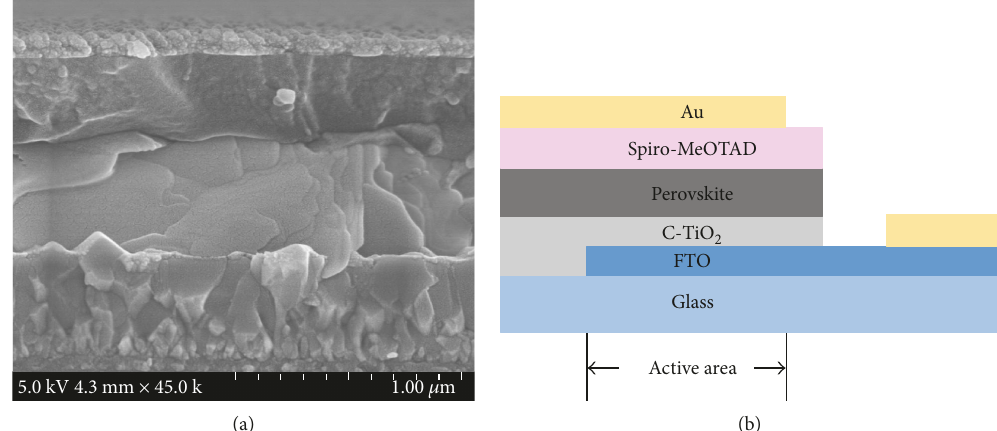
Figure 1: Representative cross-sectional SEM image (a) and schematic illustration (b) of the planar heterojunction perovskite solar cell.